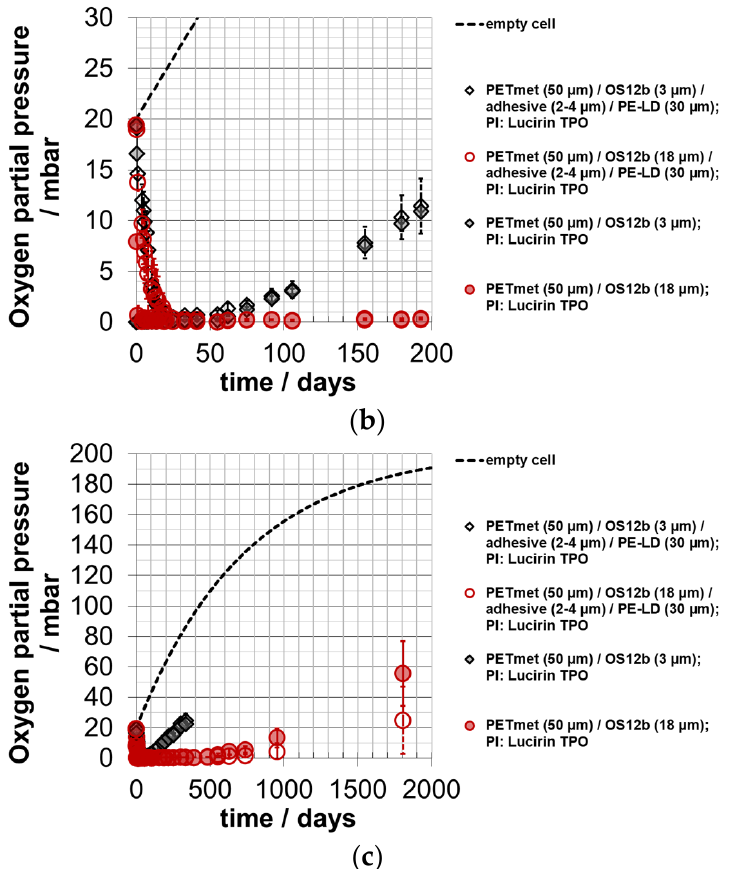
Figure 8. Oxygen partial pressure in experimental packaging; absorption of oxygen scavenger ‘ORMOCER ® OS12b’ with photo-initiator (PI) Lucirin TPO; curing time: 10 min; 0% RH; 23 °C; OS coating thickness (dry) around 3.2 ± 1.3 µm and 18.2 ± 3.5 µm; depiction ( a ) up to day 20; ( b ) up to day 200; ( c ) up to day 2000; empty cell (empty experimental packaging): calculated values .